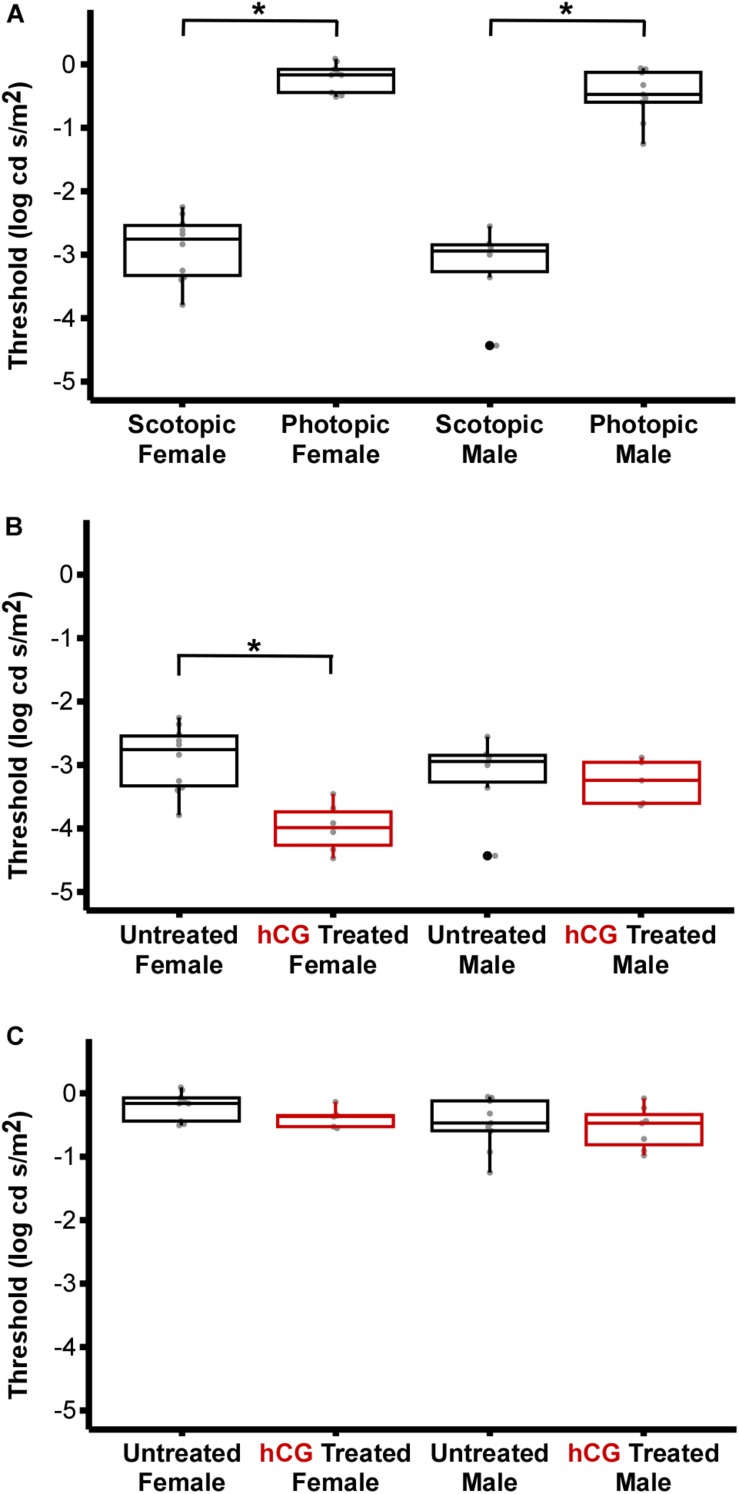
Comparison of ERG thresholds for males and females across lighting and hormone treatment conditions. (A) Within sex, scotopic vs. photopic thresholds. Scotopic are significantly lower than photopic (male, P < 0.0001; females, P < 0.0001). (B) Within sex, untreated vs. hCG treated scotopic thresholds. hCG lowered threshold in females (P < 0.0001), but not males (P = 1.000). (C) Within sex, untreated vs. hCG treated photopic thresholds. hCG had no effect in females (P = 0.9963) and males (P = 1.000). All numerical values and comparisons are in Tables 1, 2. For data dispersion presented here, the center line of each box indicates the median. The lower and upper hinges (i.e., the lower and upper boundaries of each box) mark the first and third quartiles, while each whisker stretches from the corresponding hinge to the furthest value no further than 1.5 times the interquartile range (distance between the first and third quartiles) from the hinge. Any data points beyond the whiskers are outlying points. Asterisks (∗) denote significant difference.